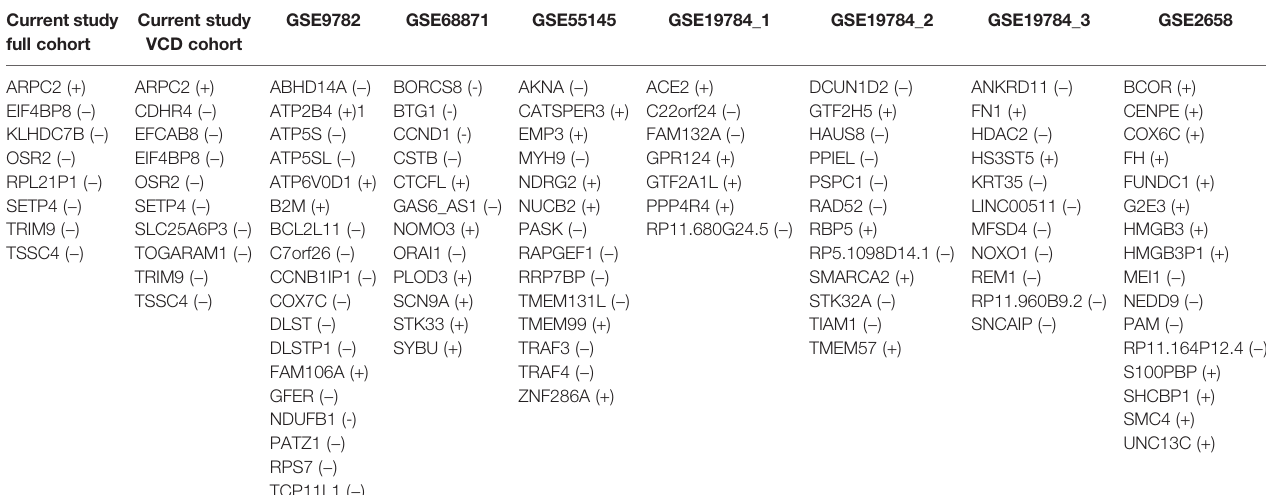
TABLE 4 | Core marker genes identi fi ed for bortezomib chemotherapy response-annotated MM datasets; genes that are overexpressed in the treatment responders are marked by (+), downregulated in the responders by ( −